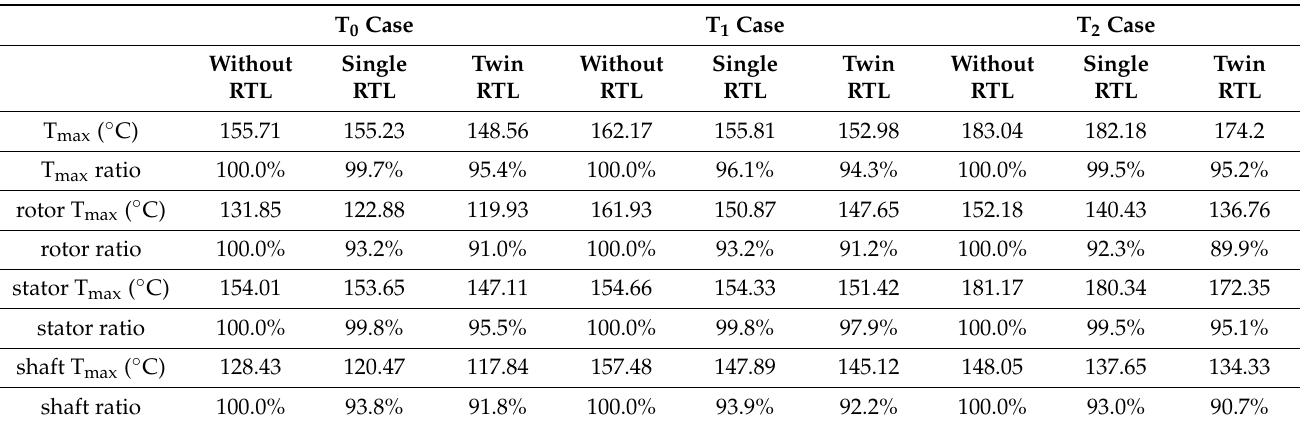
Table 3. Ratios of maximum temperatures of motor (T max ), rotor (rotor T max ), stator (stator T max ), and shaft (shaft T max ) in the PMSEMs with and without the RTLs at T 0 –T 2 conditions. T 0 Case T 1 Case T 2